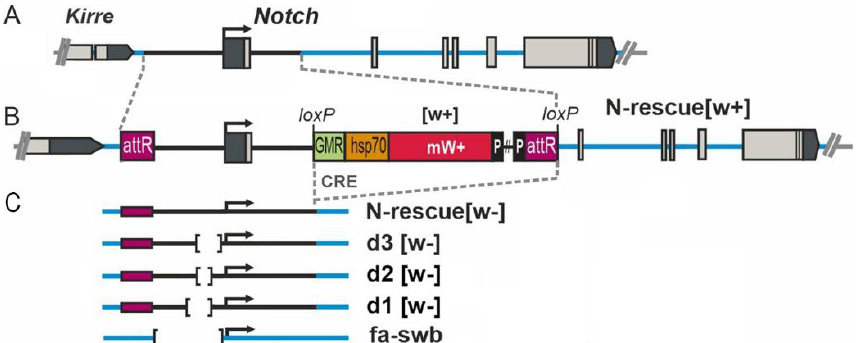
Figure 1. Locations of mutations in the 5 ′ region of the Notch gene. ( A ) The genetic map of the Notch locus. Grey boxes are exons, the thick black line is a 4 kbp fragment deleted in the founder fly strain, and the thick blue lines denote introns of the N gene. ( B ) As an example, the organization of the Notch gene in the N-resc[w+] fly line is shown, in which a full-size 4 kbp fragment from the 5 ′ region in the pGE-attB-GMR vector was utilized to reverse the deletion in the founder line through PhiC31-mediated integration. ( C ) The mini-white reporter gene and vector sequences ([w+]) were removed with the help of Cre recombinase to create the fly stocks where the engineered target region is flanked by attR and loxP sites (N-rescue[w − ] and directed deletions of the 5 ′ region of the Notch gene). The position of the N fa-swb deletion is specified too.